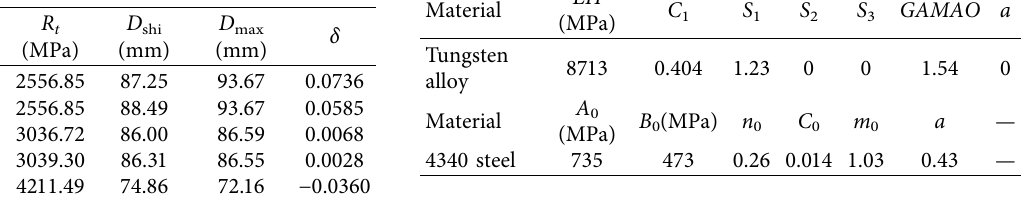
Table 1: Penetration data for long rod penetration into thick metallic targets with finite planar sizes.